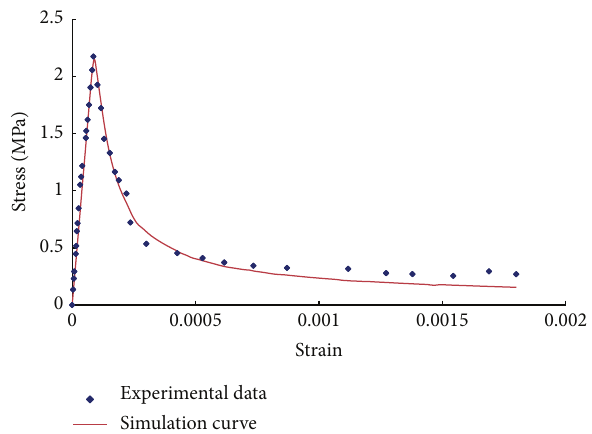
Figure 8: Comparison of stress-strain relationship between numer- ical simulation and experimental tests for specimen A4.